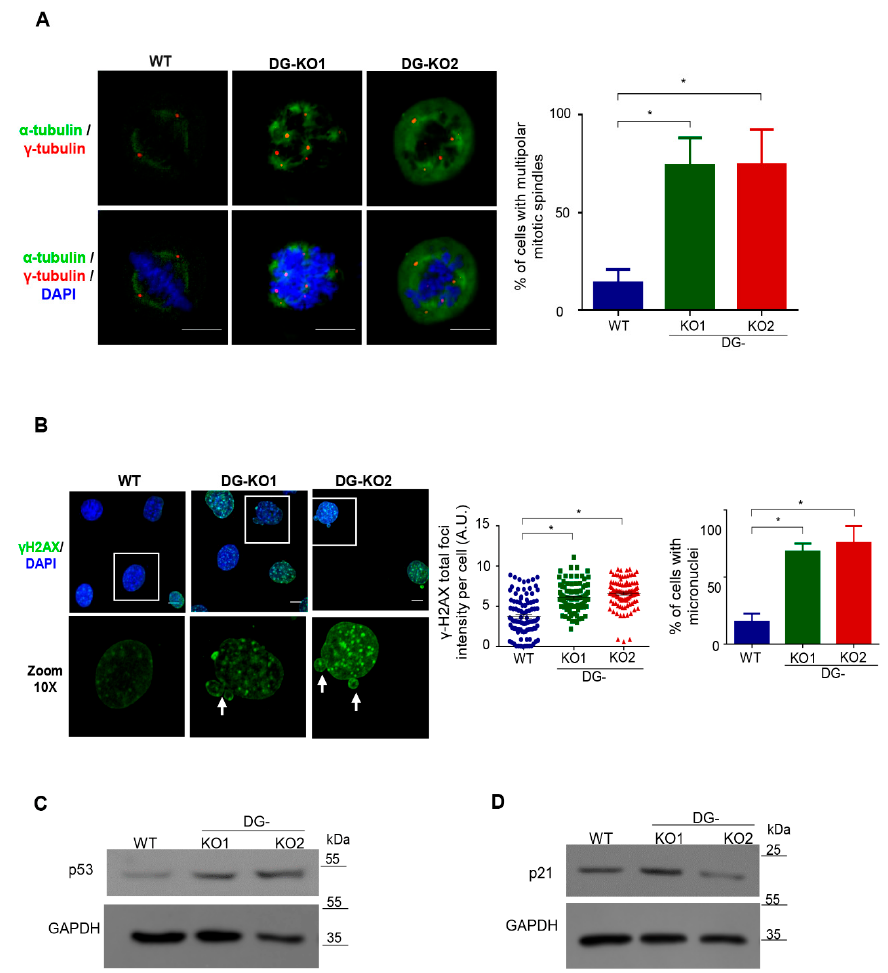
Figure 7. Mitotic failure activates a p53-dependent DNA damage response in DG-null cells. ( A ) WT, DG-KO1 and DG-KO2 cells cultured on coverslips were arrested in S phase by double treatment with